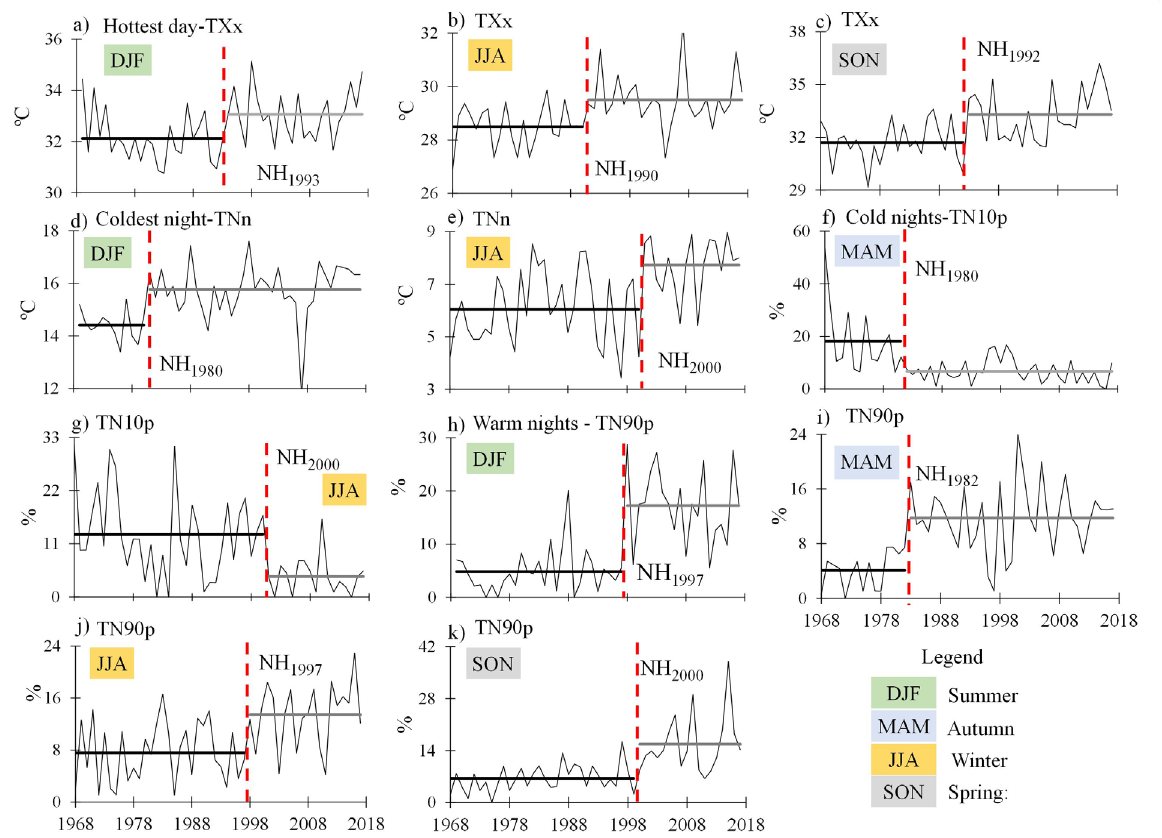
Figure 4. Temporal distribution of the extreme temperatures indices that presented abrupt changes points during 1968–2017 for the seasonal scale. Dashed red line indicates a nonhomogeneous series and the respective year of rupture